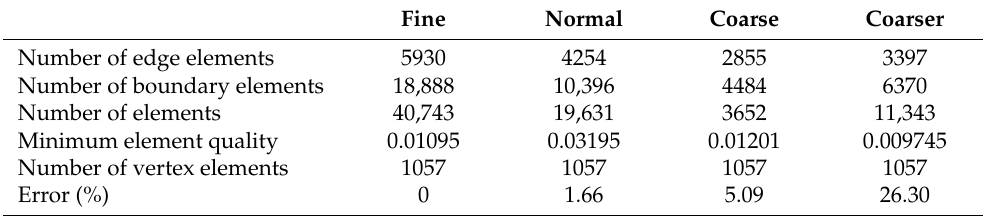
Table 2. Grid independent study: comparison between various numerical solutions.